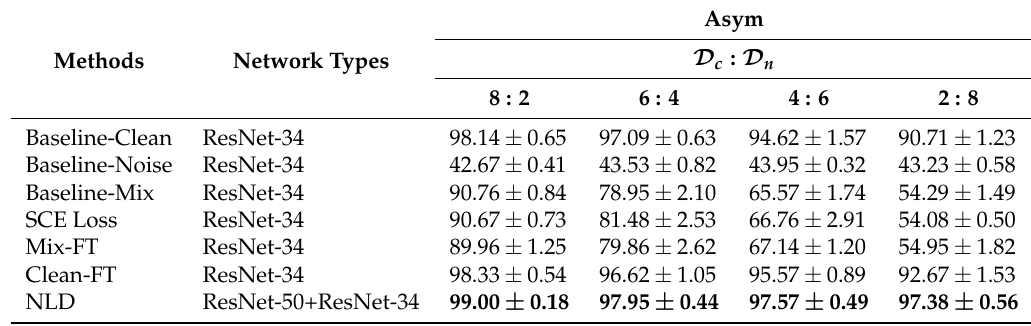
Table 5. Classification accuracy (%) on the UC Merced Land-use test set for different methods trained with asymmetric label noise. We report the mean and standard error across 5 runs.